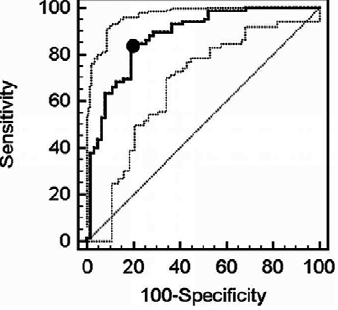
Figure 3. Receiver Operating Characteristic Curve analysis of TC/HDL-C for achieving LDL-P , 1000 nmol/L target value (solid line) with 95% CI (broken lines). The diagonal broken line indicates the line of random chance or no discrimination. cutpoint for TC/HDL-C (2.96); Sensitivity 0.82; Specificity 0.81.